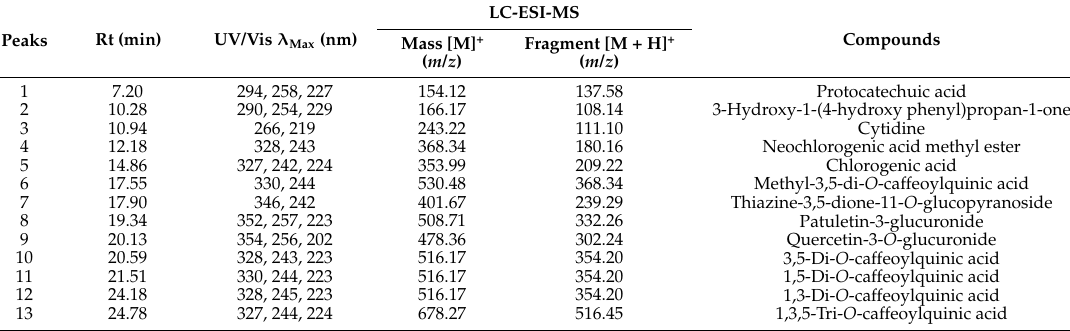
Table 1. Identification of the major compounds detected of X. strumarium by LC-ESI-MS.